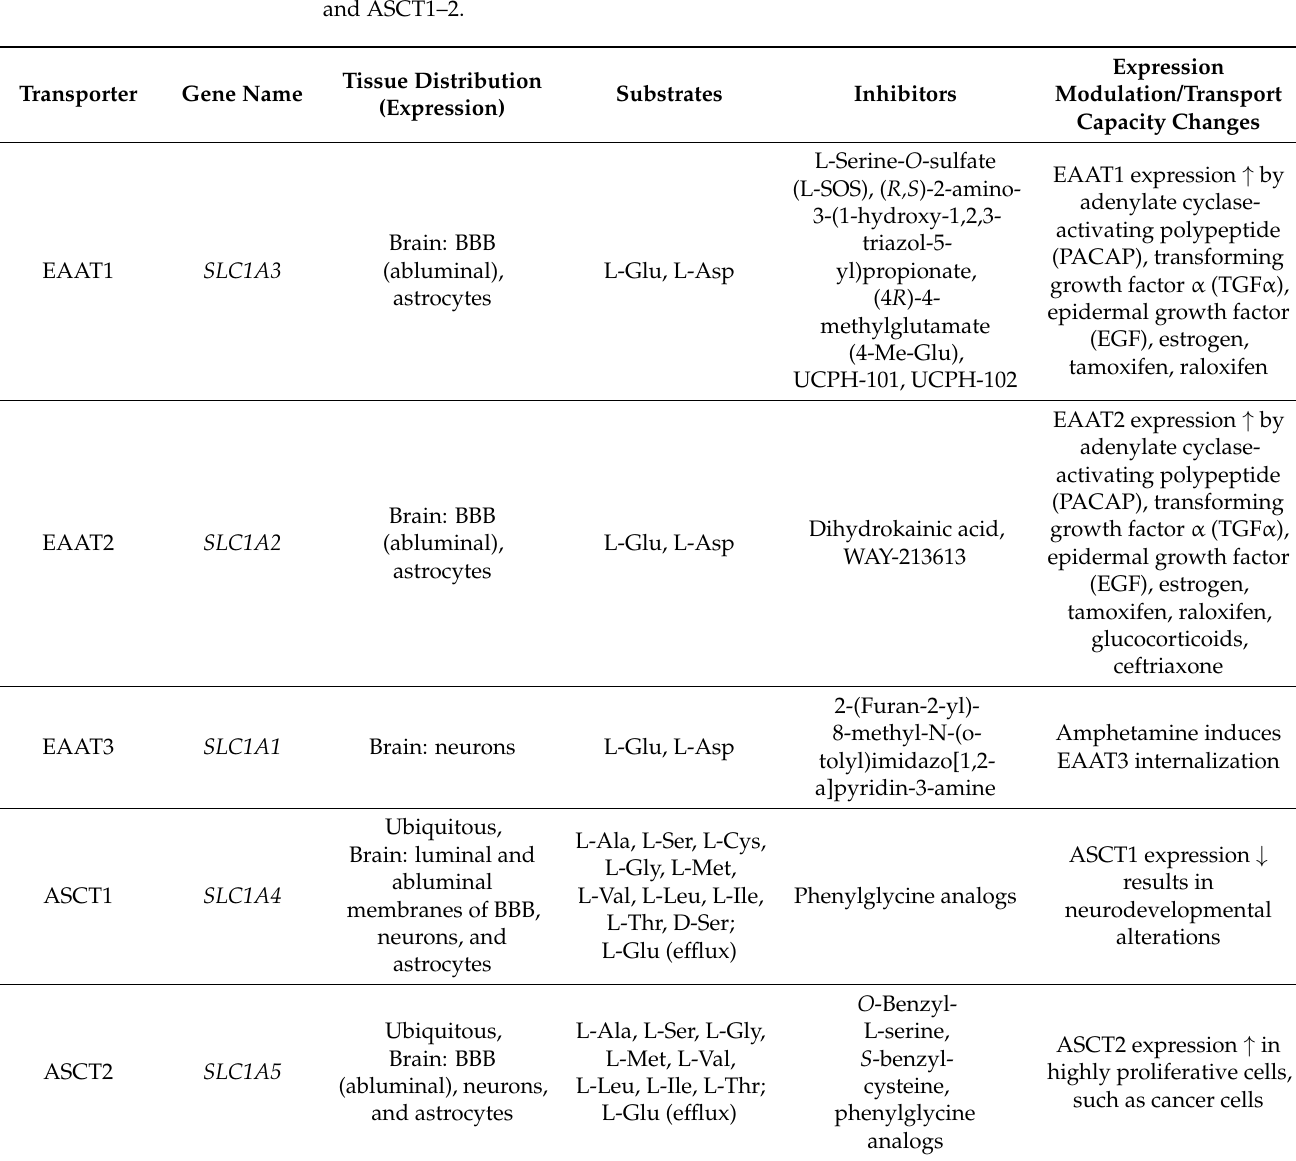
Table 1. Tissue distribution, substrates, inhibitors, and expression/function modulators of EAAT1–3 and